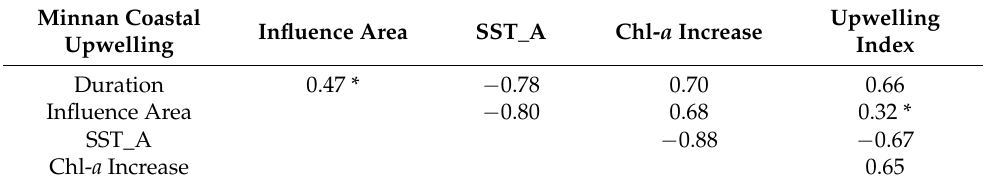
Table 2. Correlation coefficients between characteristics of Yuedong coastal upwelling (n = 20, p = 0.01). Yuedong Coastal Influence Area SST_A Chl- a Increase Upwelling Duration 0.65 − 0.67 Influence area − 0.73 0.56 SST_A − 0.84 − 0.48 Chl- a Increase 0.54